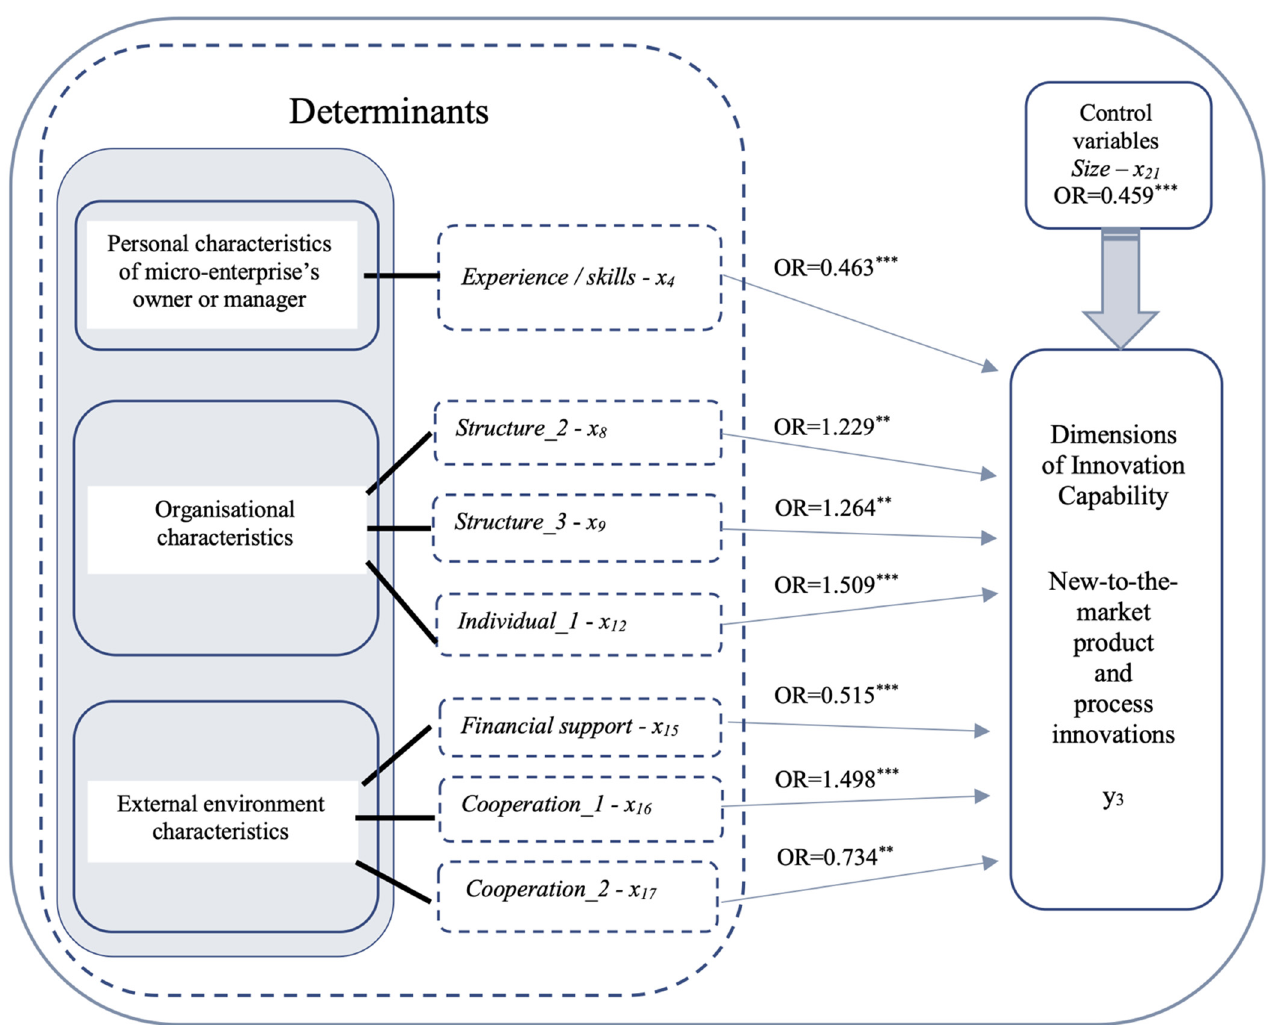
Figure 3. The determinants of innovation capability in micro-enterprises for new-to-the-market product and process innovations. *** p -value ≤ 0.01. ** p -value ≤